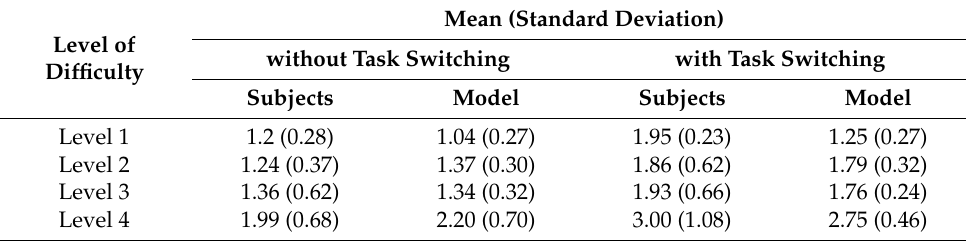
Figure 8. Performance time for a small unit task involving the selection and clicking of a card according to the presence or absence of task switching during the execution of a subtask in the memory game for ( A ) subject data and ( B ) model data. Table 5. Performance time (s) in a small unit task for selecting and clicking a card according to the presence or absence of task switching in the memory game for subject and model data.